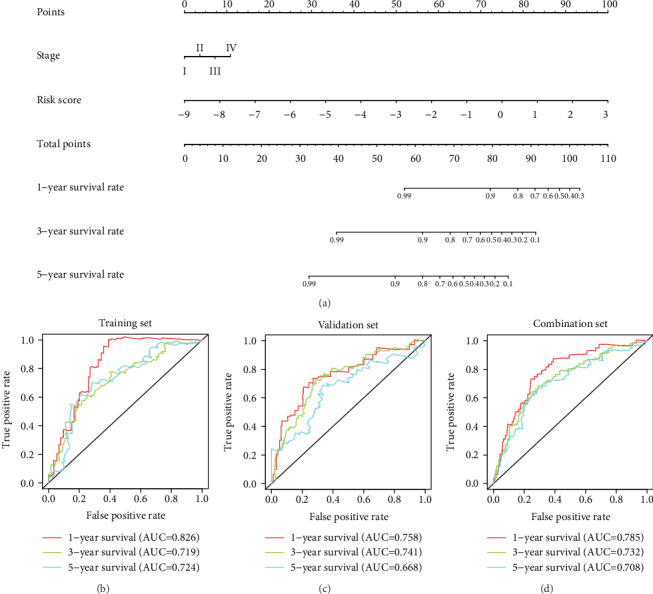
Building and validation of the nomogram predicting overall survival for lung adenocarcinoma patients in the training set. (a) The nomogram built based on the TNM stage and risk signature. (b–d) ROC curves of the training set, validation set, and combination set. ROC: receiver operating characteristic.